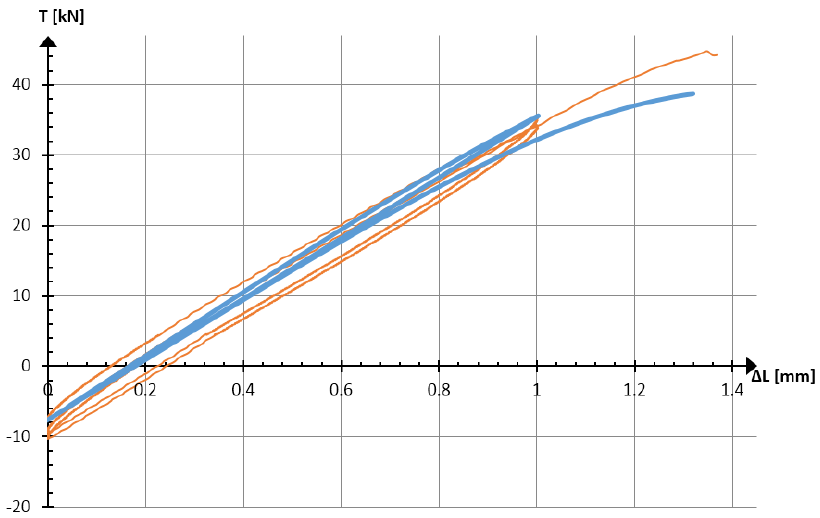
Figure 19. Numerical ( blue ) and experimental comparison for joint sample “I” ( orange ).